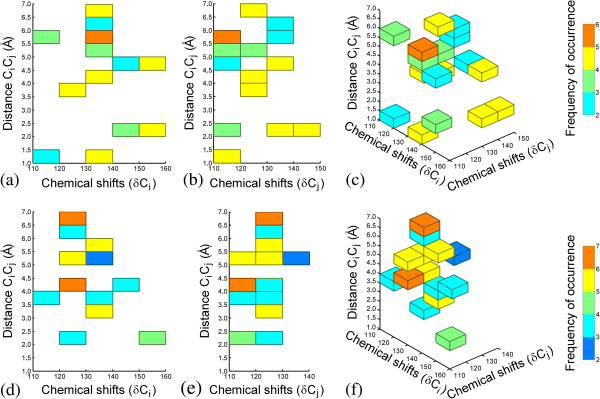
Orthographic projections in the planes XZ (Figures 7a and7d) and YZ (Figures 7b and7e) of the most frequently occurring bins with positive and negative PLS weights mapped back to the 3D-QSDAR abstract space shown on Figures7c and7f.